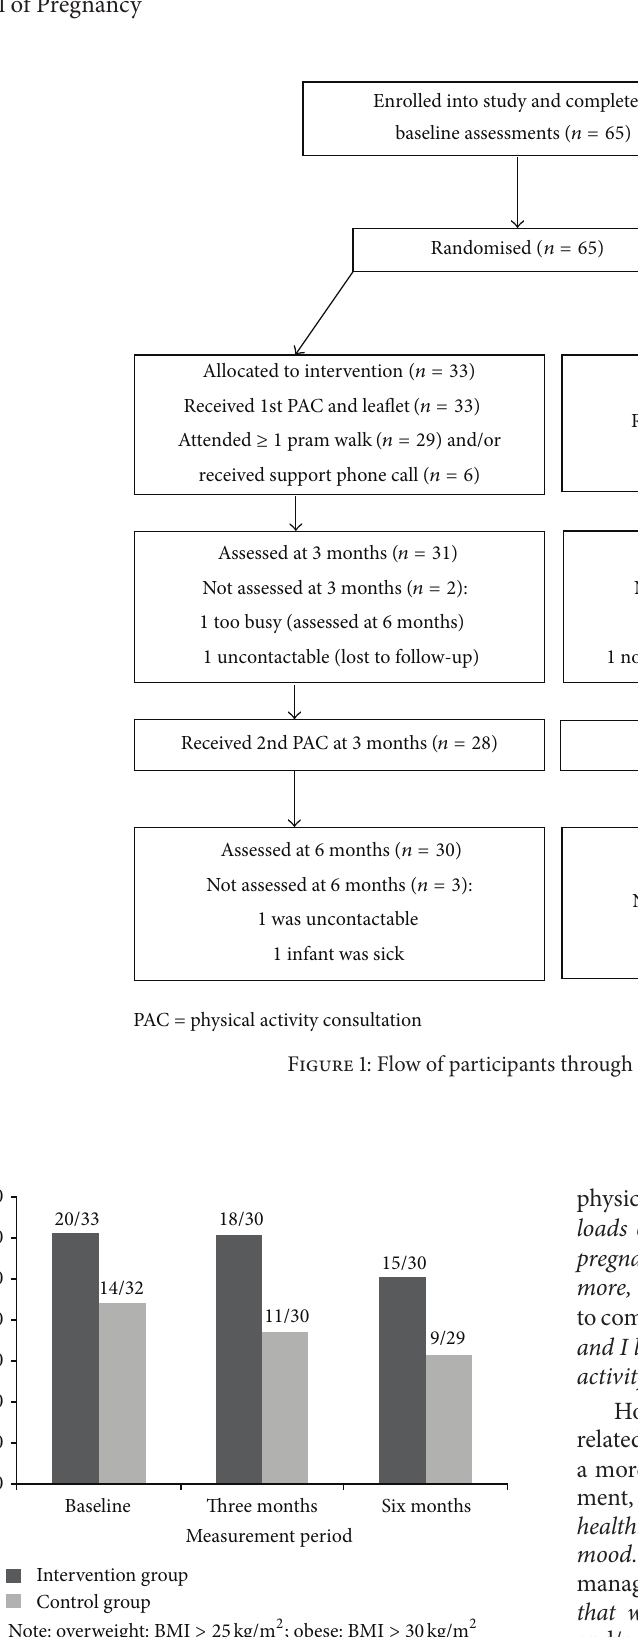
Figure 2: Proportion of overweight and obese participants at baseline and three and six months in response to a 10-week physical activity